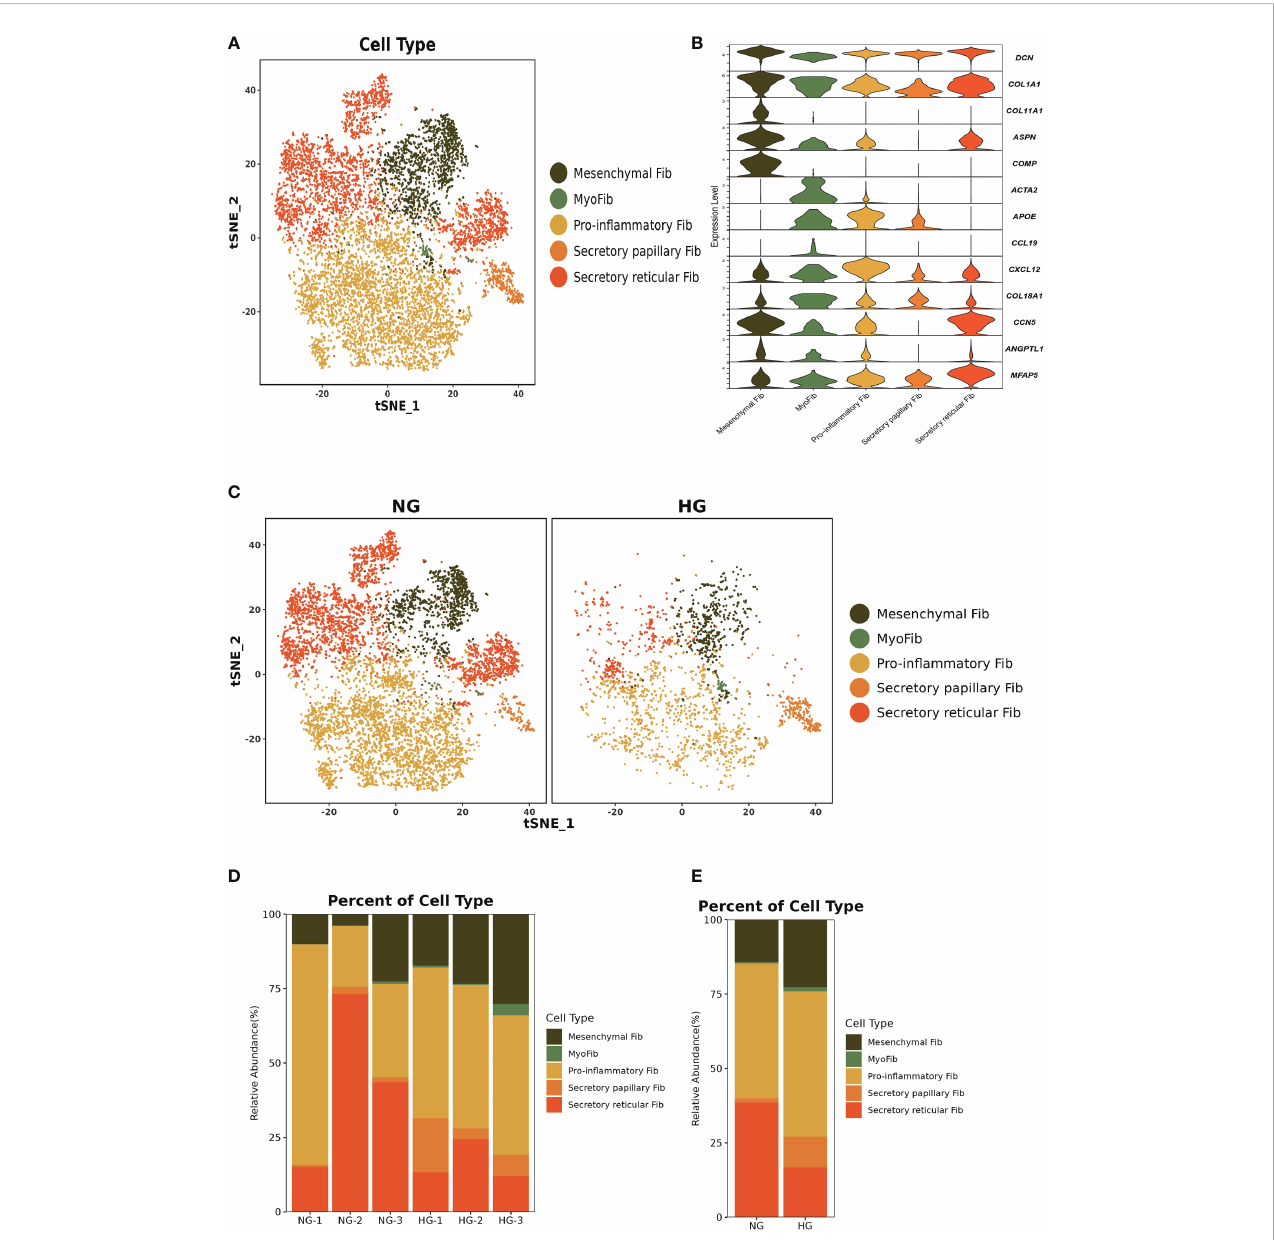
FIGURE 7 Clustering and classi fi cation of the fi broblasts (Fib) subclusters of deep fascia tissue (A) tSNE visualization of fi broblasts subclusters from deep fascia tissue. (B) Violin plots showing marker genes across fi broblasts subclusters. (C) tSNE visualization of fi broblasts subclusters from deep fascia tissue in HG and NG. (D) Bar plots showing the relative percentage of fi broblasts subclusters for each sample. (E) Bar plots showing the relative percentage of fi broblasts subclusters in HG and NG. HG, high stress group; NG, normal stress group.